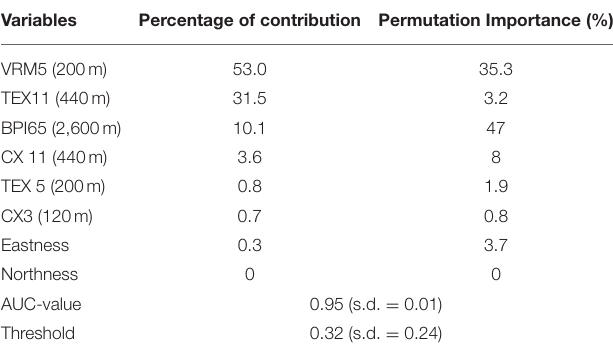
TABLE 3 | Percentage of contribution and permutation importance (in percent) for each variable used in the final Maxent model applied for Cold-Water coral in the SML